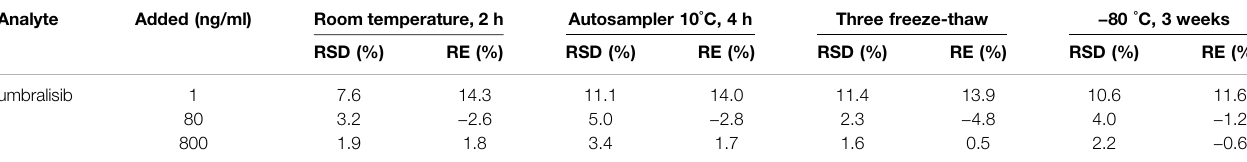
TABLE 4 | Stability results of umbralisib in plasma under different conditions ( n (cid:1) 6). Analyte Added (ng/ml)